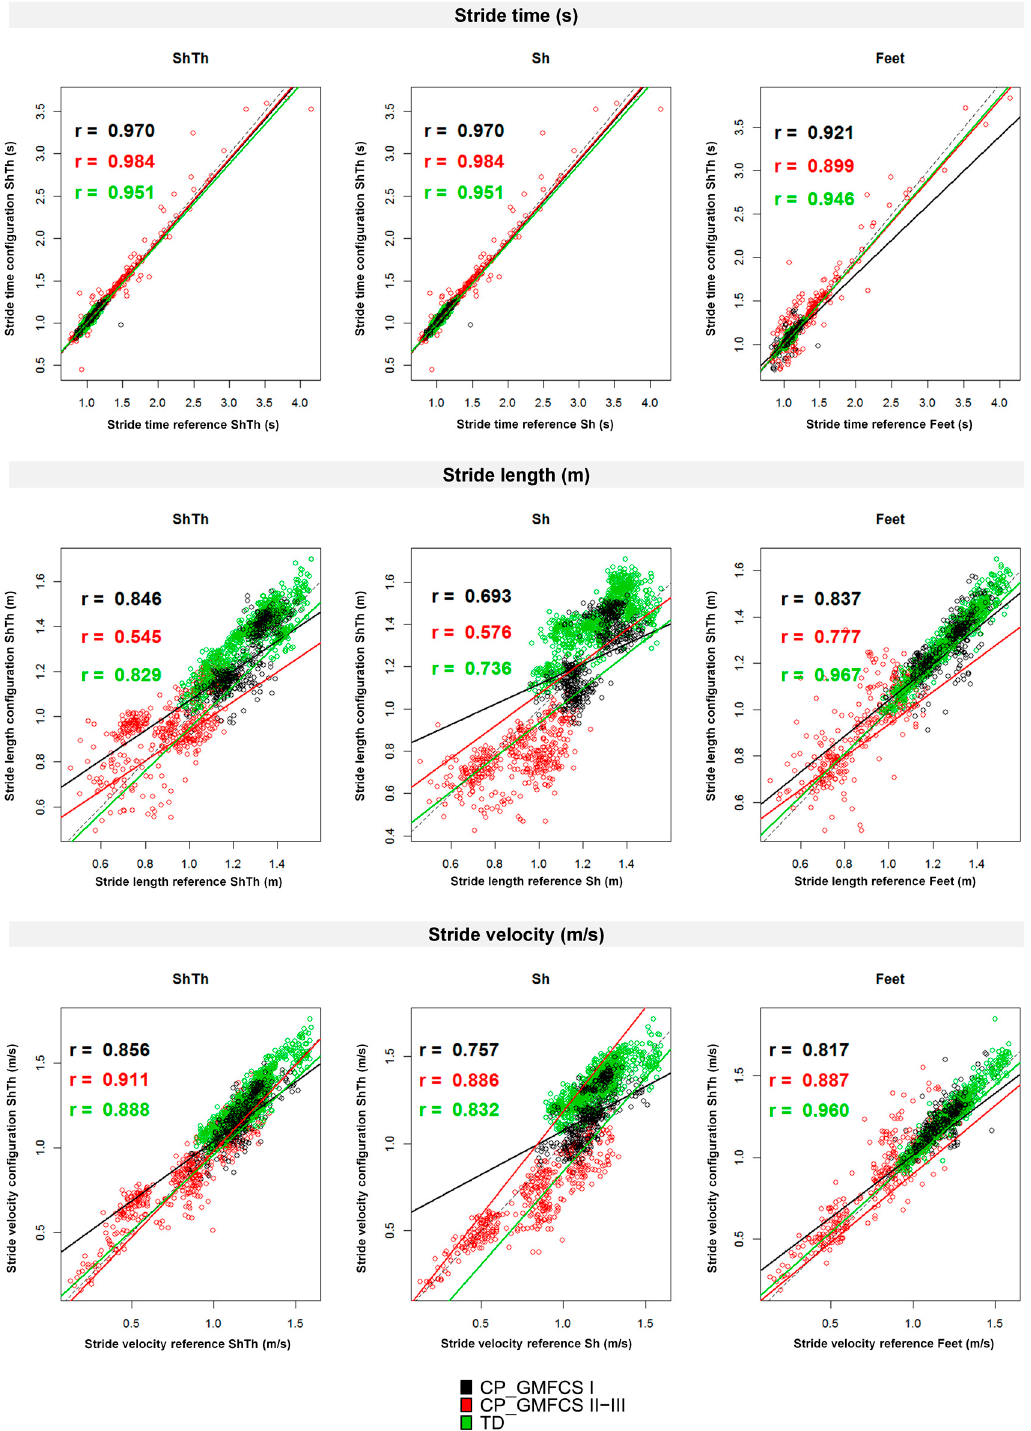
Figure 3. Correlations between the wearable configurations (ShTh, Sh, and Feet) and the optoelectronic system for the three spatiotemporal parameters (stride time, stride length, and stride velocity). Spearman’s correlation coefficients are reported. Dashed lines represent y = x . Green: TD; Black: CP-GMFCS I level; and Red: CP-GMFCS II-III levels.